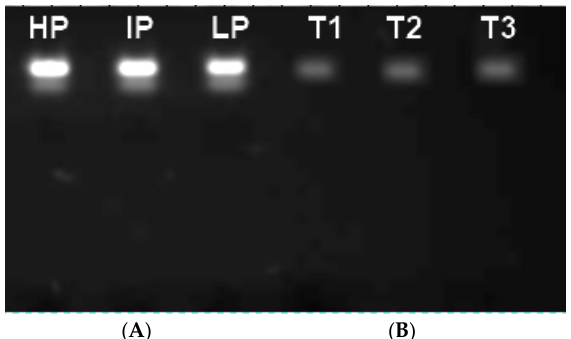
Figure 10. Agarose gel electrophoretic pattern of the fungal genomic DNA treated with 180 ppm of Cu-Chit / NCs gel, ( A ) Lanes 1–3: DNA for untreated A. flavus isolates, Lane 1: A. flavus (high producer (HP) isolate), Lane 2: A. flavus (intermediate producer (IP) isolate), Lane 3: A. flavus (low producer (LP) isolate). ( B ) Lanes T1, T2, and T3, three A. flavus isolates DNA treated with Cu-Chit / NCs gel, showed total damage to fragmented DNA